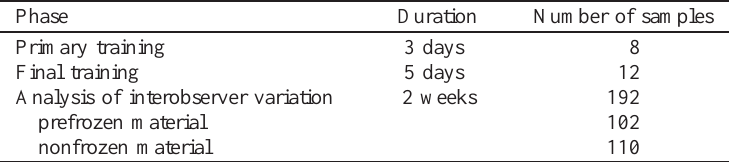
Table 1 The samples examined by the observers 1 and 2 during the training